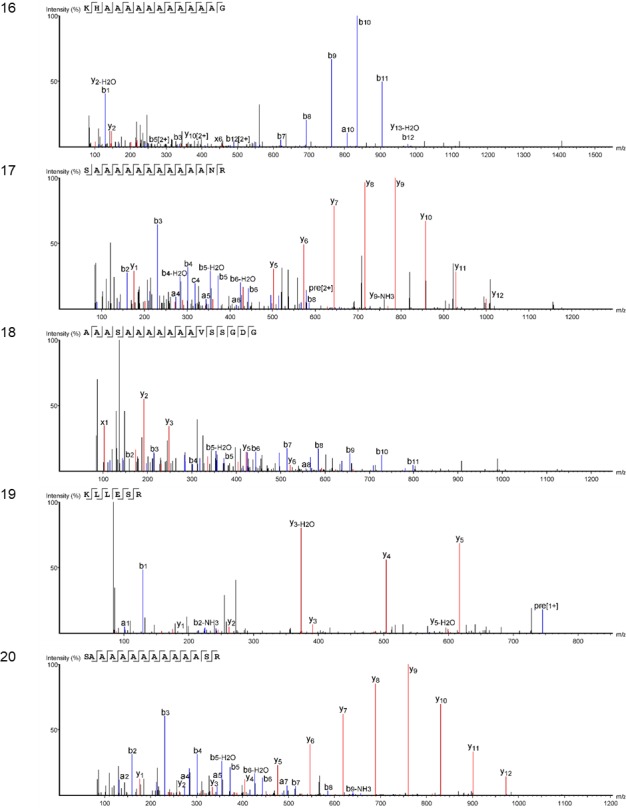
Product ion spectra [16 - 20] supporting the coverage of protein Hic74 identified in the double-button HavC.